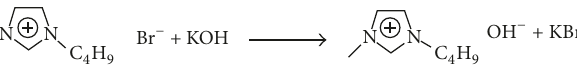
Scheme 1: Preparation of ionic liquid [bmim]OH.